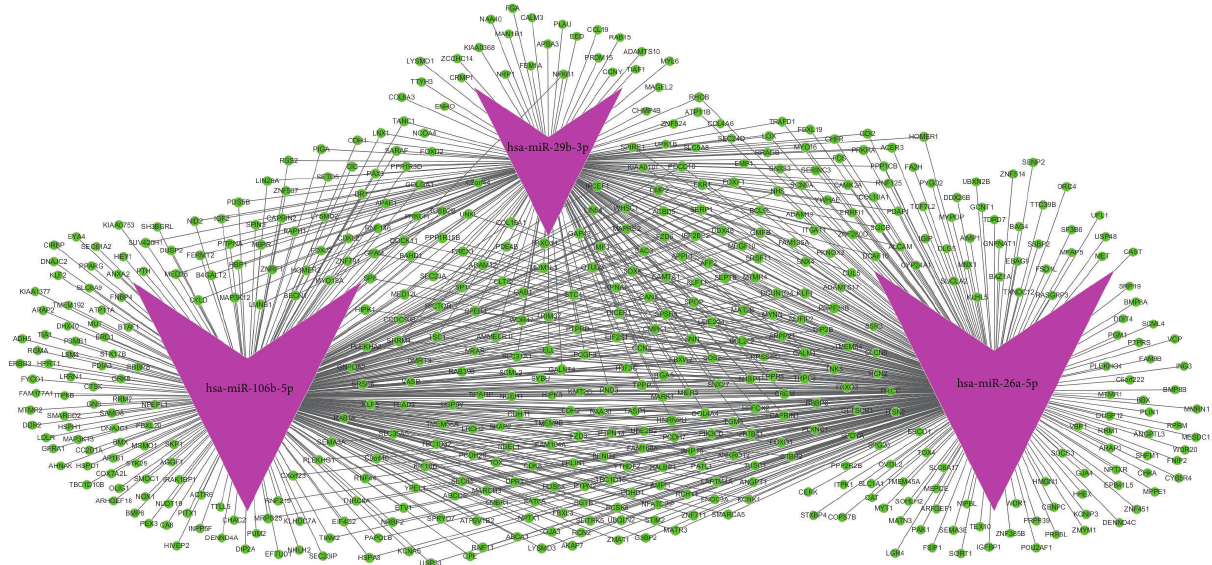
Figure 3: Prediction of mRNA targets regulated by the 3 miRNA signatures. The network includes two types of nodes, the miRNAs (purple arrow) and their predicted mRNA targets (green circle), based on miRTarBase, MicroCosm, and TargetScan databases. We selected the top 10 term targets to create the mRNA-miRNA interaction network and then visualized the data using